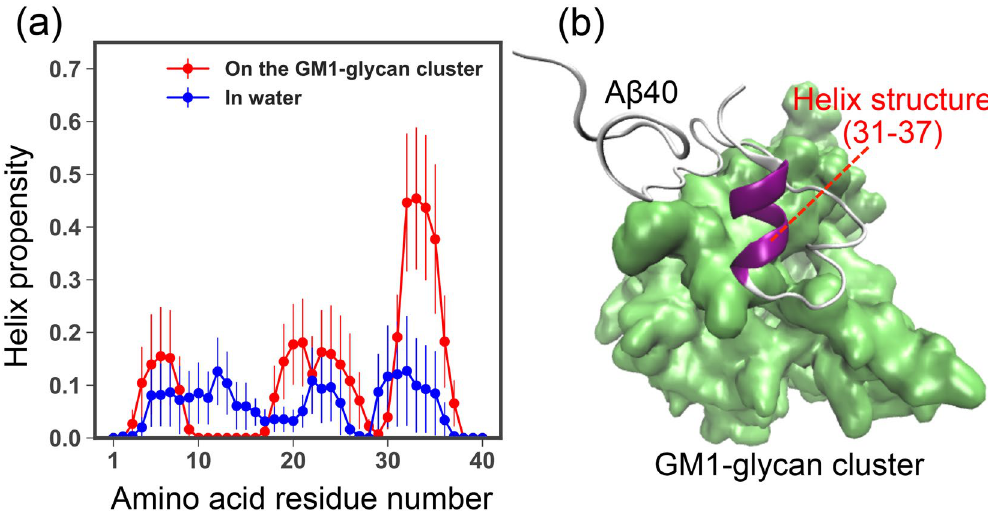
Figure 5. ( a ) Helix propensities in each amino acid residue assigned by the DSSP algorithm 44 . The Jackknife method 45 was used for estimating the average values and standard errors from correlated time series. ( b ) A typical snapshot of A β 40 with a helix structure formed in residues 31–37. Green colored molecule is the GM1- glycan